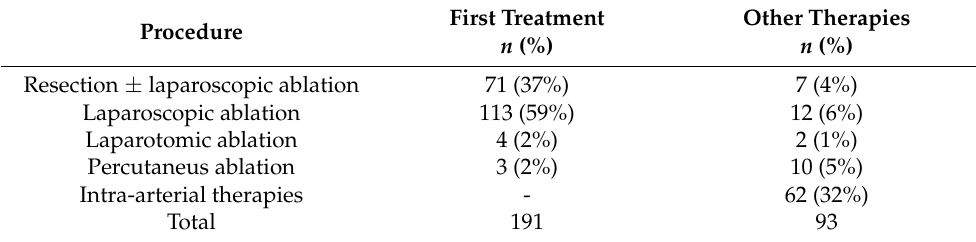
Table 1. Summary of downstaging procedures in the Padua